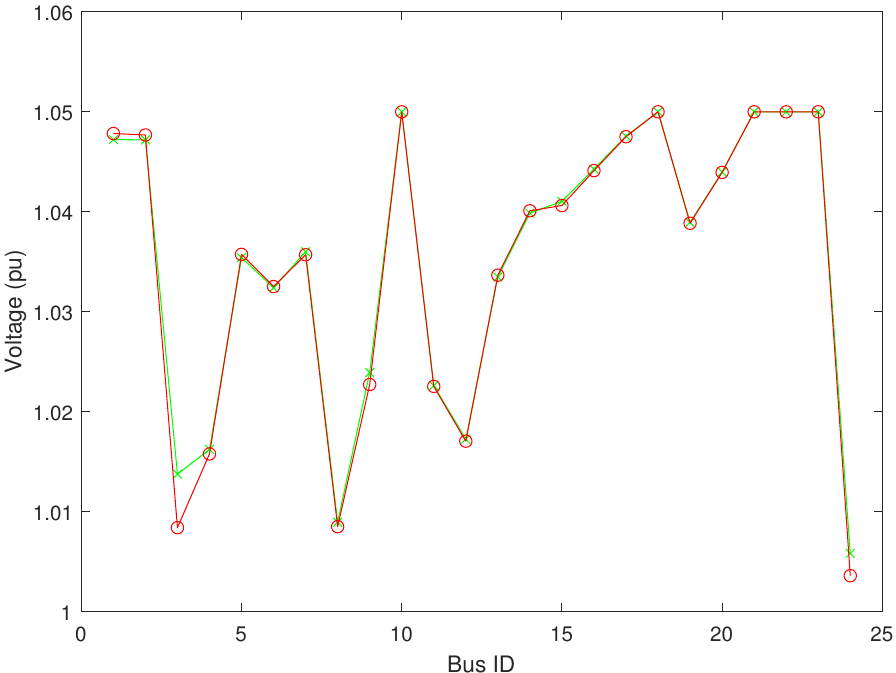
Figure 6. DB attack with line parameter alteration of a single line.